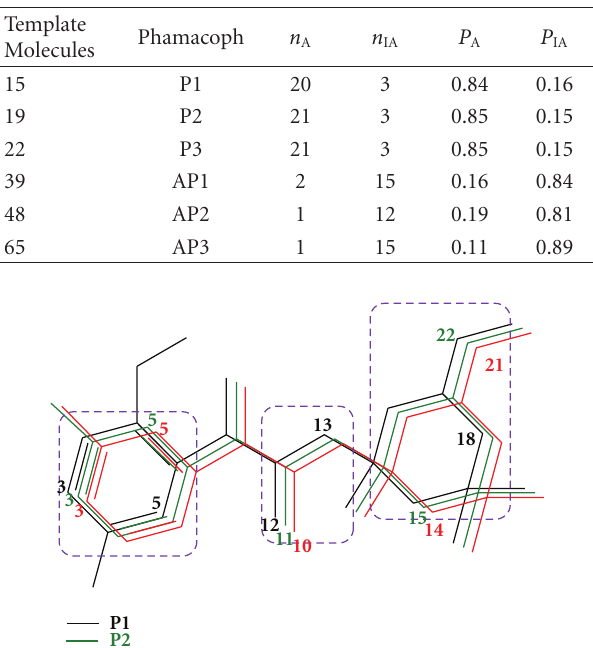
these regions play an important role in the ligand-receptor